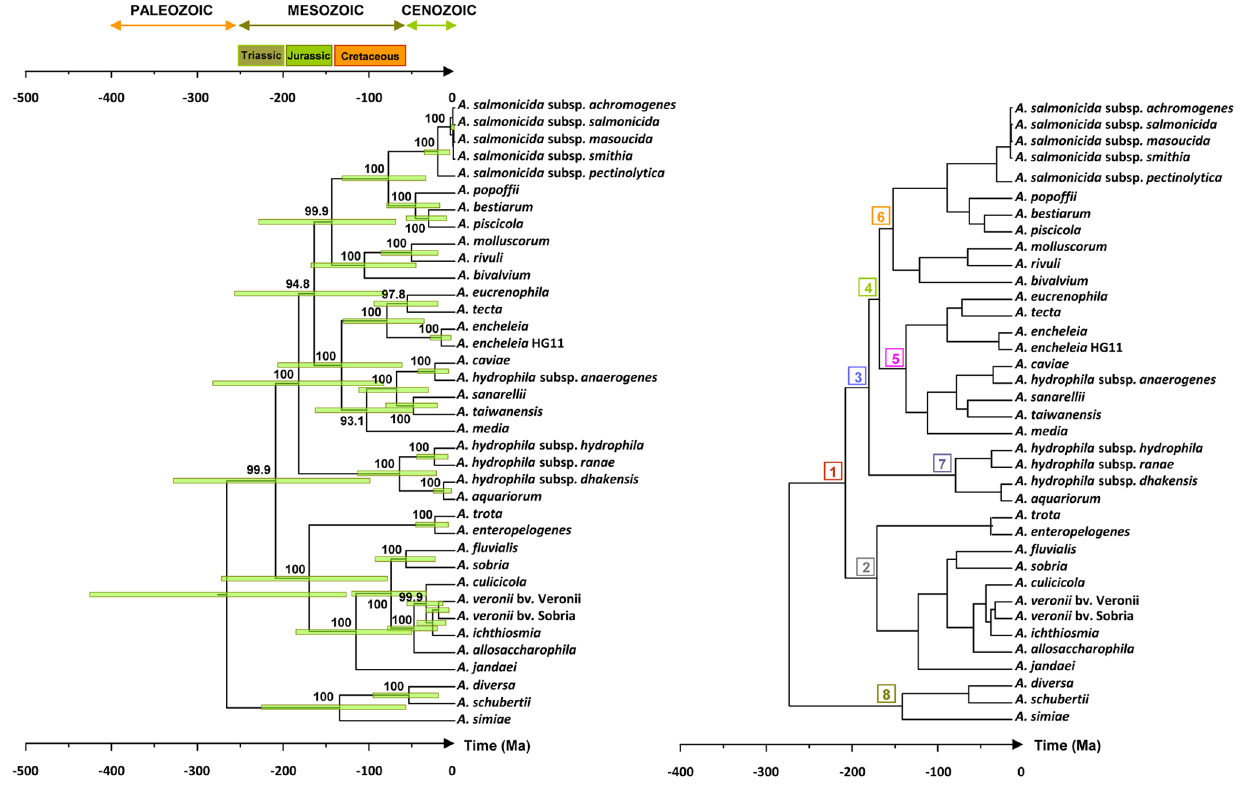
Figure 2. Molecular chronograms of Aeromonas . Chronograms were estimated using Bayesian (left) and MLA (right) methods. Bars at the node intersections in the Bayesian chronogram indicate 95% Highest Posterior Density (HPD). Bayesian posterior probability values are shown at the nodes. Time scale is indicated in Mega Annum (Ma). Major Aeromonas species clades are indicated by numbers within squares in the MLA chronogram.